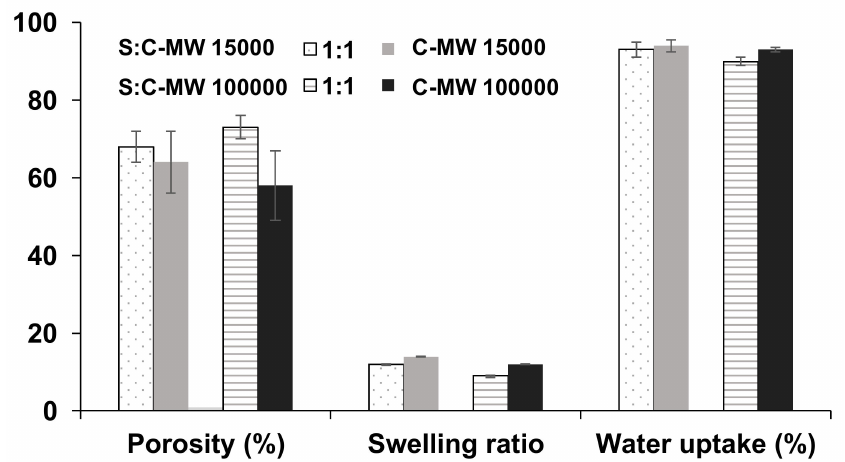
Figure 4. E ff ect of MW of chitosan on porosity, swelling ratio, and water uptake of sericin-chitosan sca ff old with chitosan MW of 15,000 g / mol and 100,000 g / mol at a ratio of 1:1 and pure chitosan.